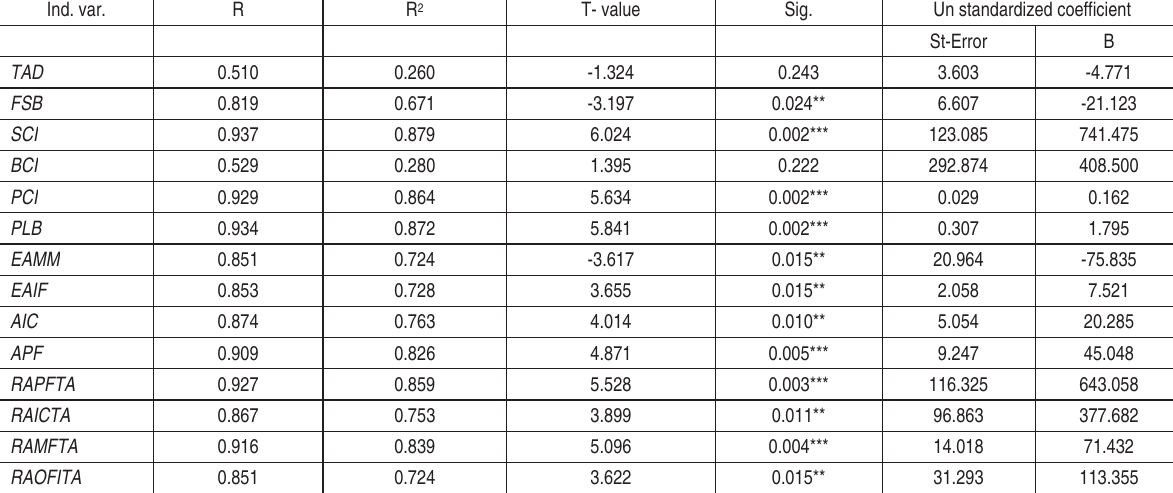
Table 3 (cont). Regression analysis of structural indicators for the European Union banking system on GDP at current market prices